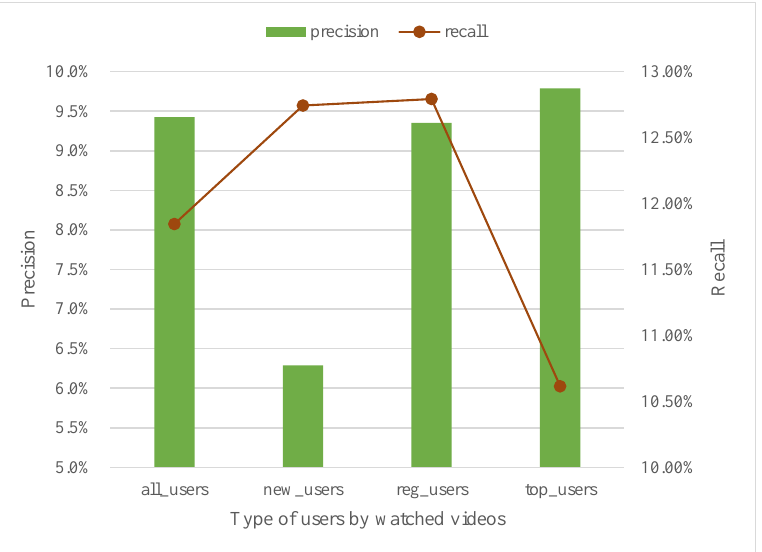
Figure 9. Production results of precision and recall by different type of users within the 120 min after the recommendation. All users include the total amount of users that received any recommendation. New users are those that watched between 1 and 9 videos, regular users watched 10 to 150 videos, and top users watched more than 150 videos.